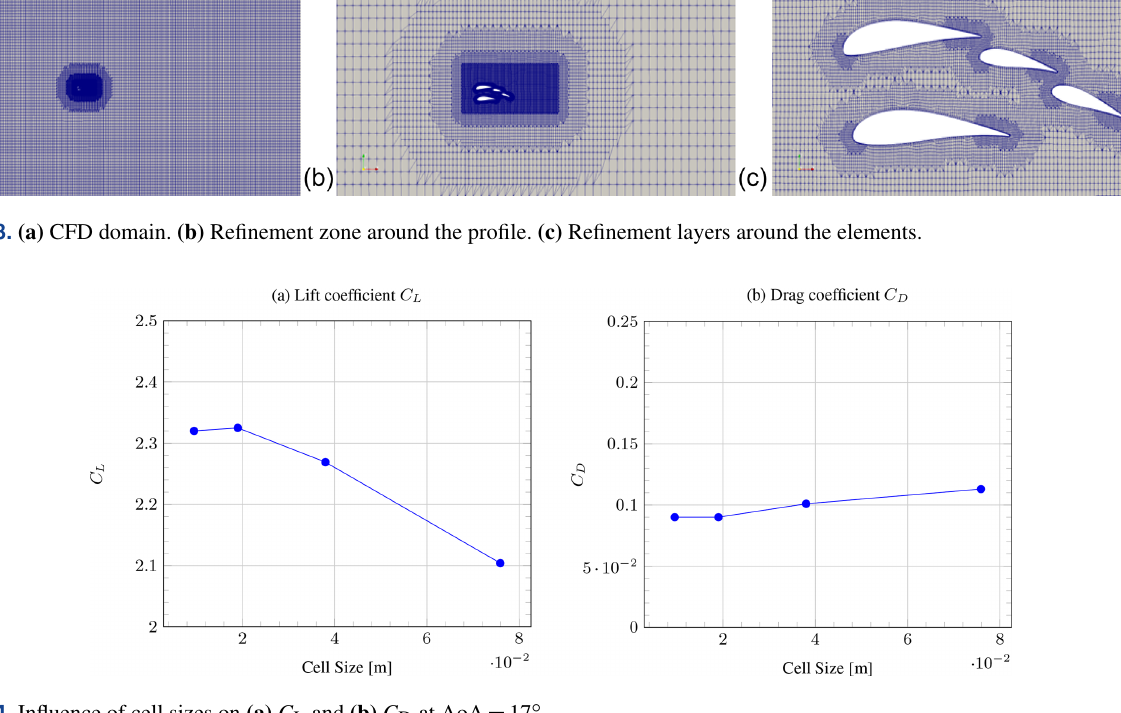
Figure 4. Influence of cell sizes on (a) C L and (b) C D at AoA = 17 ◦